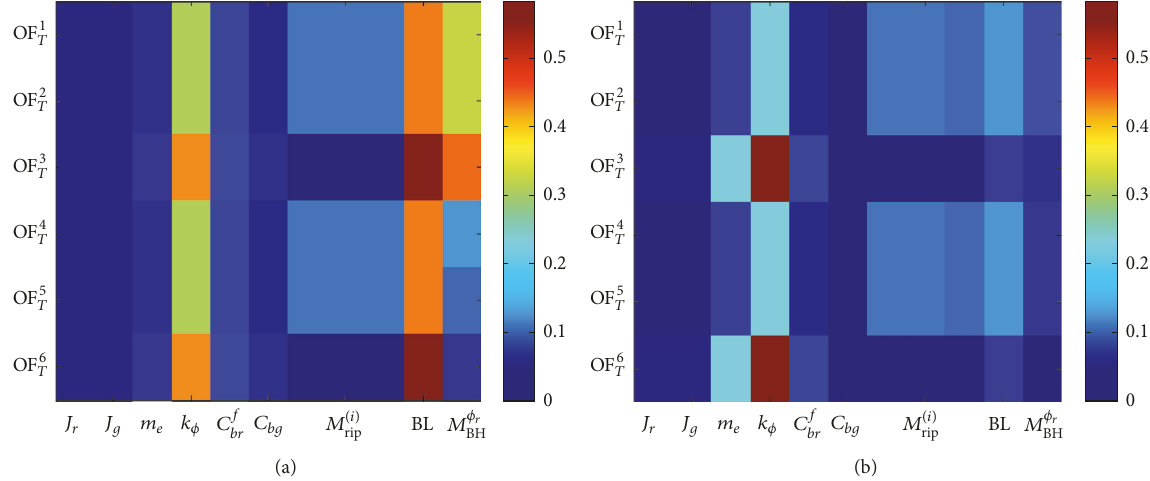
Figure 15: Primary sensitivity 𝑆 𝑖 (a) and total sensitivity ST 𝑖 (b) indices for torsional model for OS 1 with backlash.